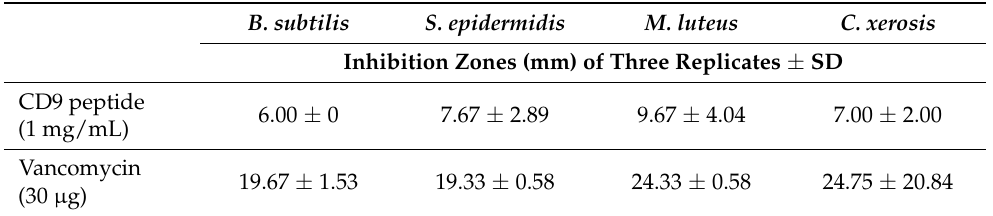
Table 2. The minimum inhibitory concentration (MIC) and minimum bactericidal concentration (MBC) of CD9 tetraspanin peptides against armpit bacterial flora. Figure 2. MBC of CD9 tetraspanin peptide against M. luteus on blood agar. Inhibition of bacterial biofilm by CD9 peptide showed that S. epidermidis was excel- lently inhibited, as the absorbance values decreased significantly from (0.120 ± 0.004) to Figure 1. Inhibitory effects of CD9 tetraspanin peptide on armpit bacterial flora. VA: Vancomycin, P: (0.065 ± 0.003) in the presence of the CD9 tetraspanin peptide (Table 3). The optical density CD9 Peptide. values of B. subtilis and C. xerosis (0.090 ± 0.003) and (0.083 ± 0.002) were significantly re-